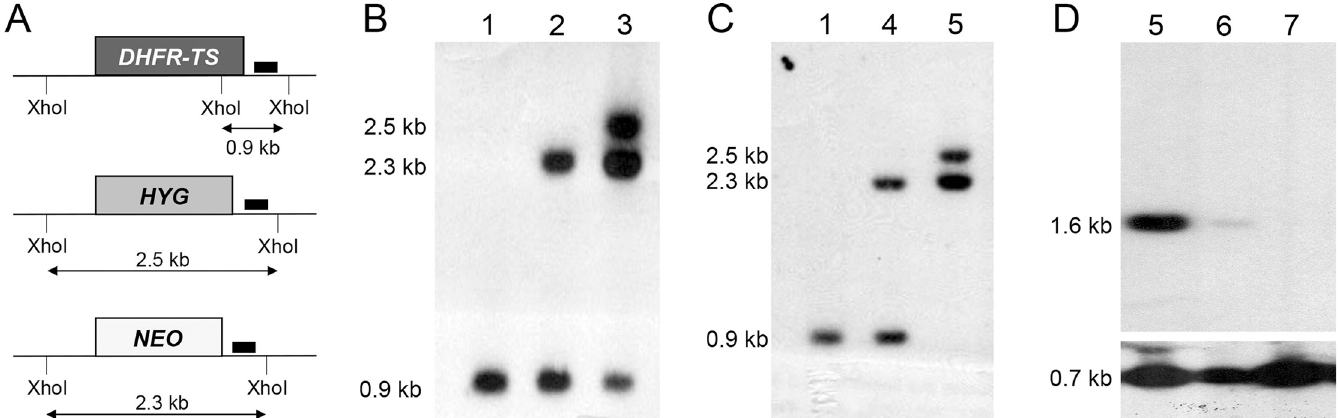
Fig 3. Deletion of the DHFR-TS gene in Leishmania infantum . (A) Schematic representation of the DHFR-TS locus and of the integration of the hygromycin phosphotransferase B (HYG) and neomycin phosphotransferase (NEO) deletion cassettes. Also shown are the expected sizes after digestion with XhoI and the location of probe 1 (small black boxes) used for the hybridization of Southern blots. (B) Southern blot analysis of genomic DNAs digested with XhoI from L . infantum wild-type (1), the single allele knock out DHFR-TS NEO/+ (2), or the aneuploid cell DHFR-TS NEO/HYG/+ (3) hybridized to probe 1. (C) Southern blot analysis of genomic DNAs digested with XhoI from L . infantum wild-type (1), the single allele knockout clone DHFR-TS NEO/+ transfected with psp72 α blast α -DHFR-TS (4), or the DHFR-TS NEO/ HYG null mutant harboring psp72 α blast α -DHFR-TS (5) with probe 1. (D) Southern blot analysis of total DNAs digested with XbaI and HindIII (see S2A Fig) from a clone of the DHFR- TS NEO/HYG chromosomal null mutant harboring psp72 α blast α -DHFR-TS (5) or of these cells grown for 20 (lane 6) and 25 (lane 7) passages without blasticidin but supplemented with 50 μ g/ml of thymidine. This blot was hybridized to a DHFR-TS intragenic probe (see S2 Fig). The blot was re-hybridized with a PTR1 probe to monitor the amount of DNA analyzed (lower